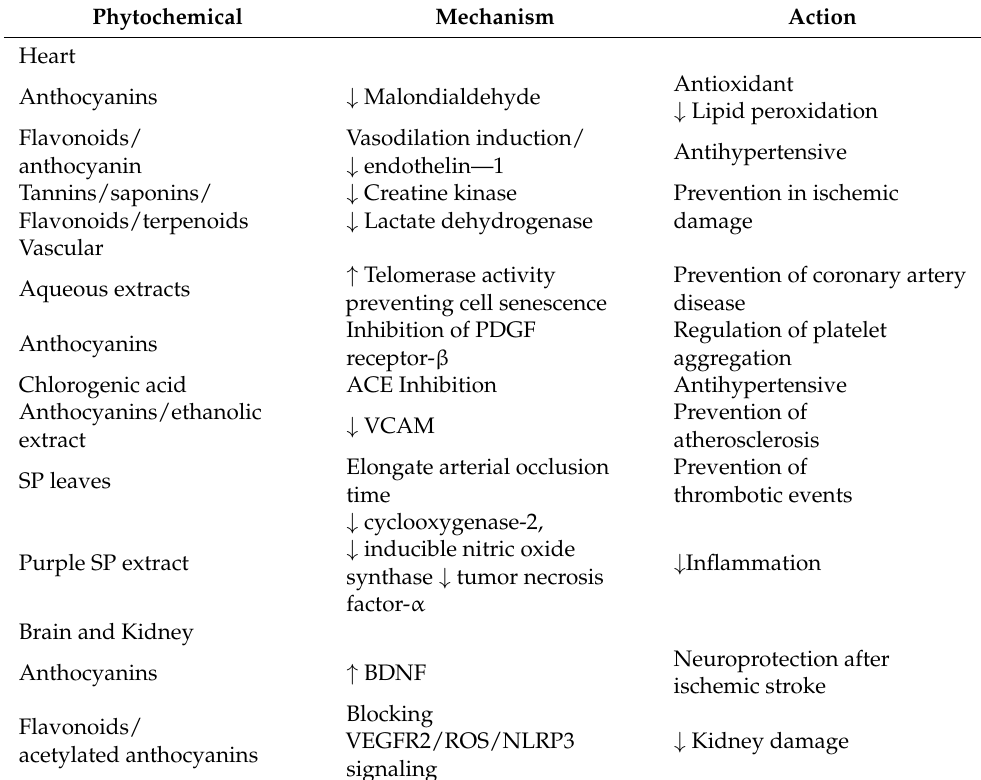
Table 5. SP phytochemicals in cardiovascular diseases